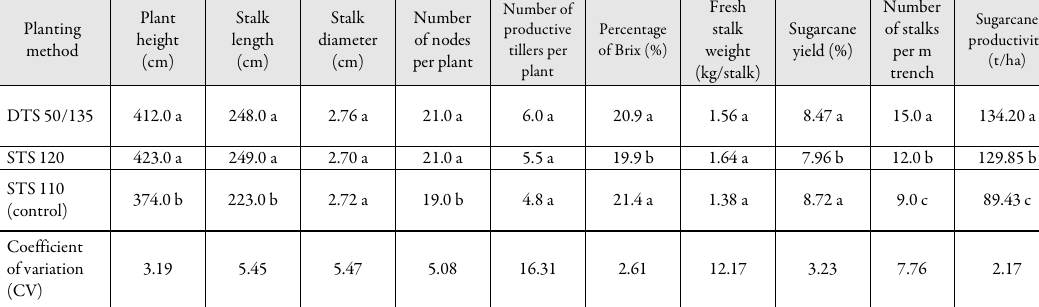
Table 2. Sugarcane growth and yield performances under different planting methods in SR-1 Planting method